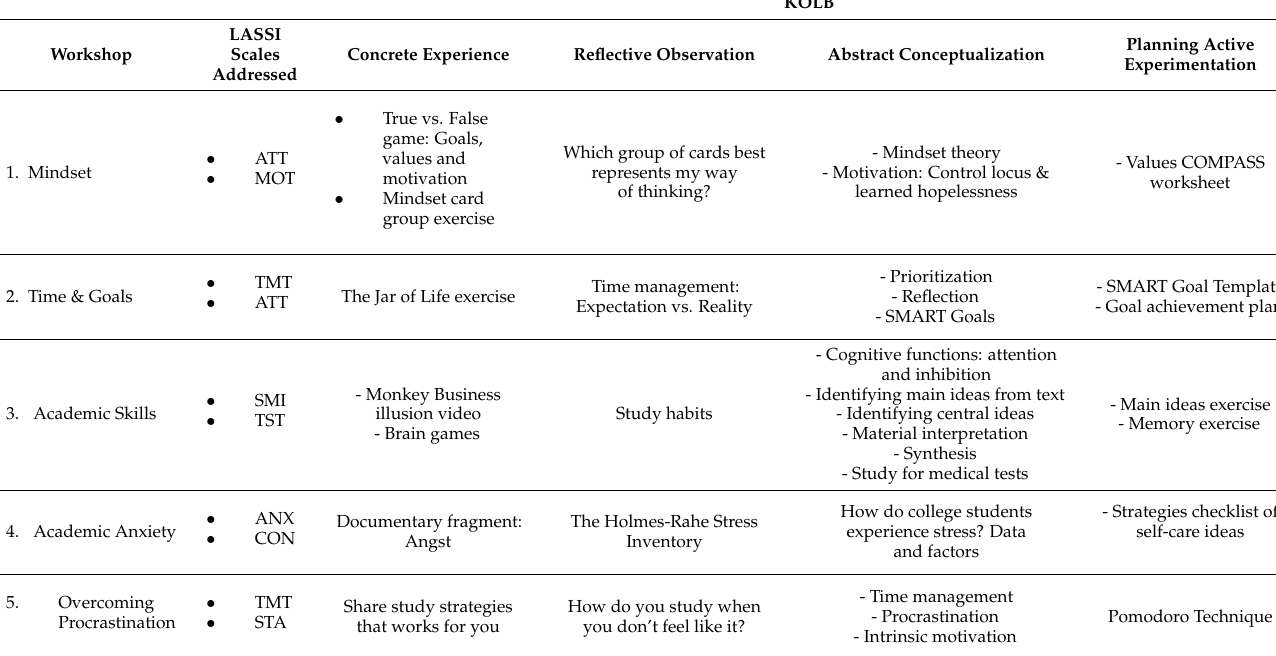
Table 1. Overview of the five workshops implemented for the USFQ’s Keys to Academic Success Program.